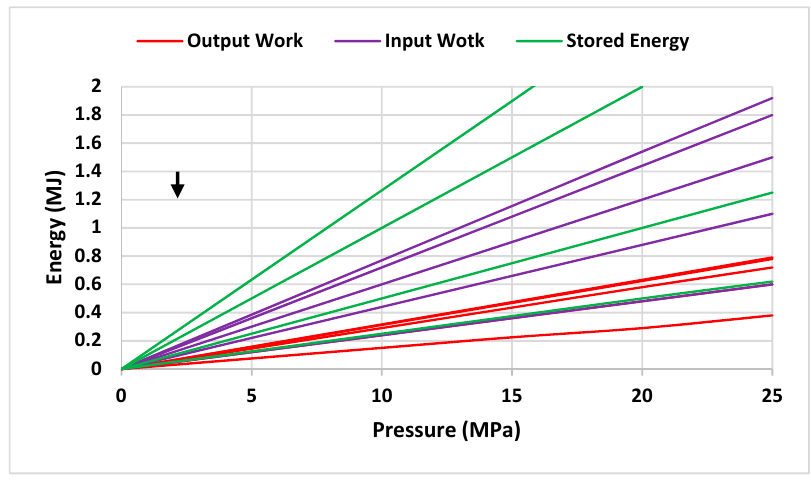
Figure 13. Changes in input work, output work, and stored energy relative to pressure for different values of α with a tank volume of 1000 m 3 .